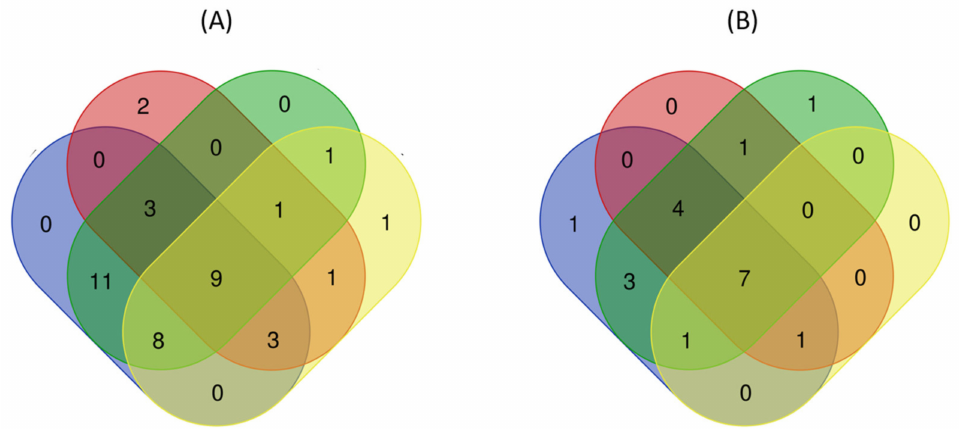
Figure 5. Venn diagram of ( A ) dysregulated metabolites and ( B ) perturbed metabolic pathways in wheat after one-week foliar exposure to NMs suspensions. Legend: wheat leaves exposed to Cu(OH) 2 NMs; wheat leaves exposed to MoO 3 NMs; wheat roots exposed to Cu(OH) 2 NMs; wheat roots exposed to MoO 3